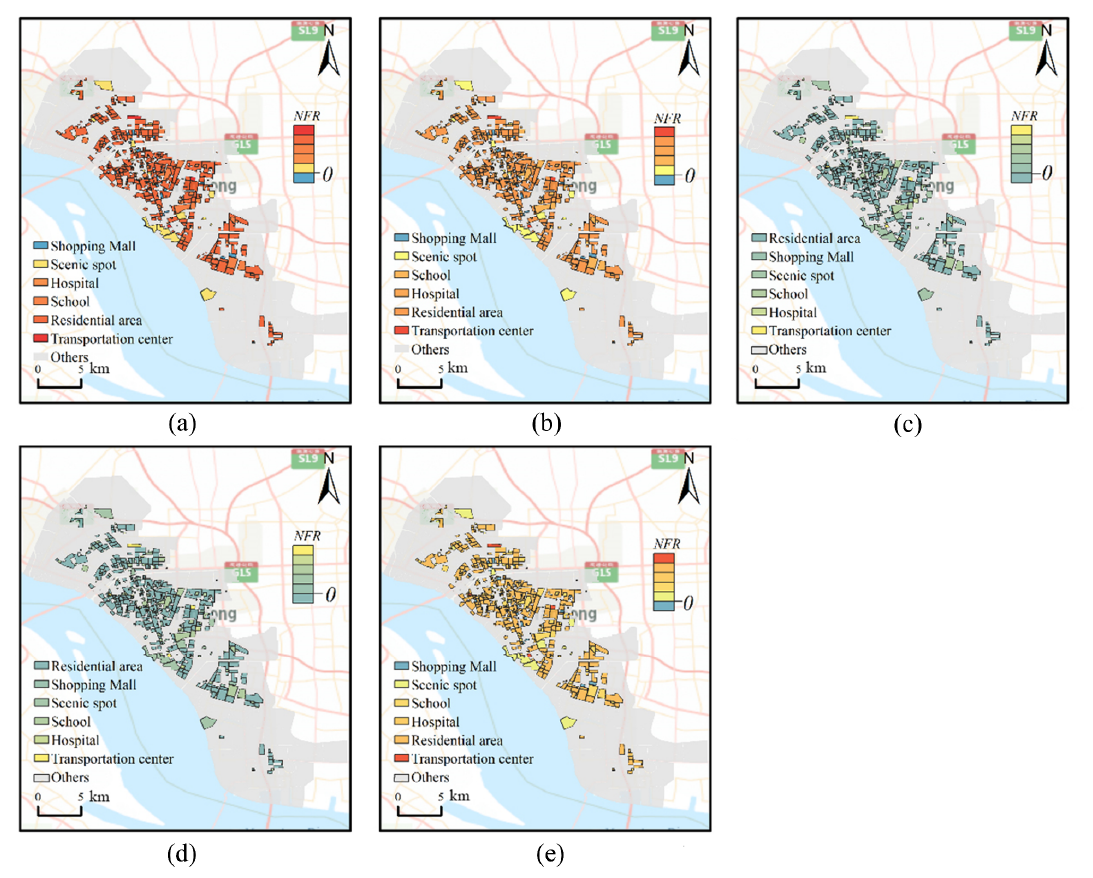
Figure 11. NFR of UFAs in ( a ) normal period of society, ( b ) early period of COVID-19, ( c ) outbreak period of COVID-19, ( d ) rework period of society, and ( e ) recovery period of society. NFR represents the net flow rate. UFAs represent urban functional areas.